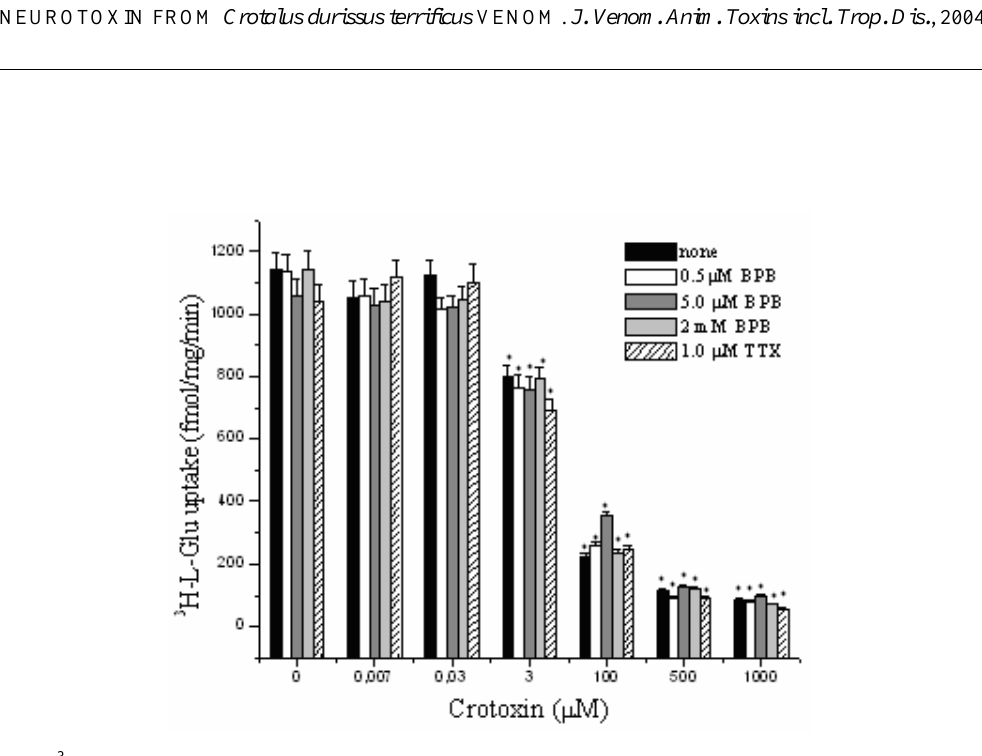
Figure 6. 3 H-L-glutamate uptake by RCCS. BPB was incubated with the toxin at different concentrations for 1h at room temperature. 1 µ M of TTX was previously incubated with RCCS for 30 min before the uptake assay. (** p<0.01